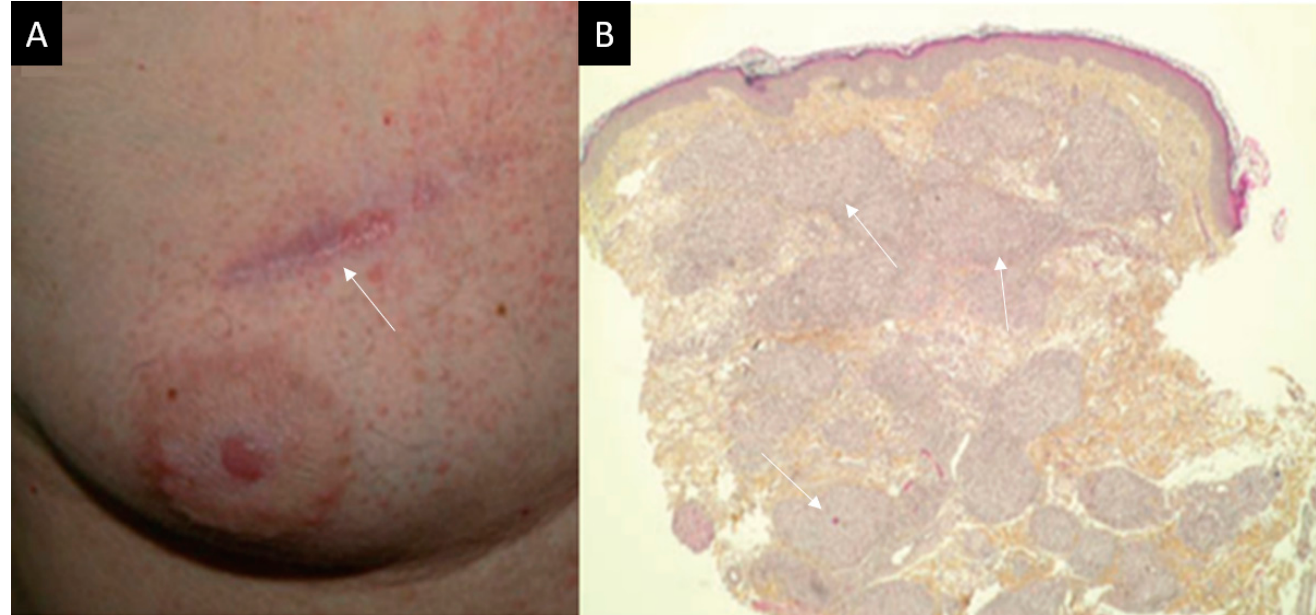
Figure 3. ( A ) Skin nodules on a scar of the anterior chest (white arrow). ( B ) Biopsy specimen of the skin lesion stained with haematoxylin–eosin–saffron showing numerous granulomas (white arrows); original magnification: ×200.